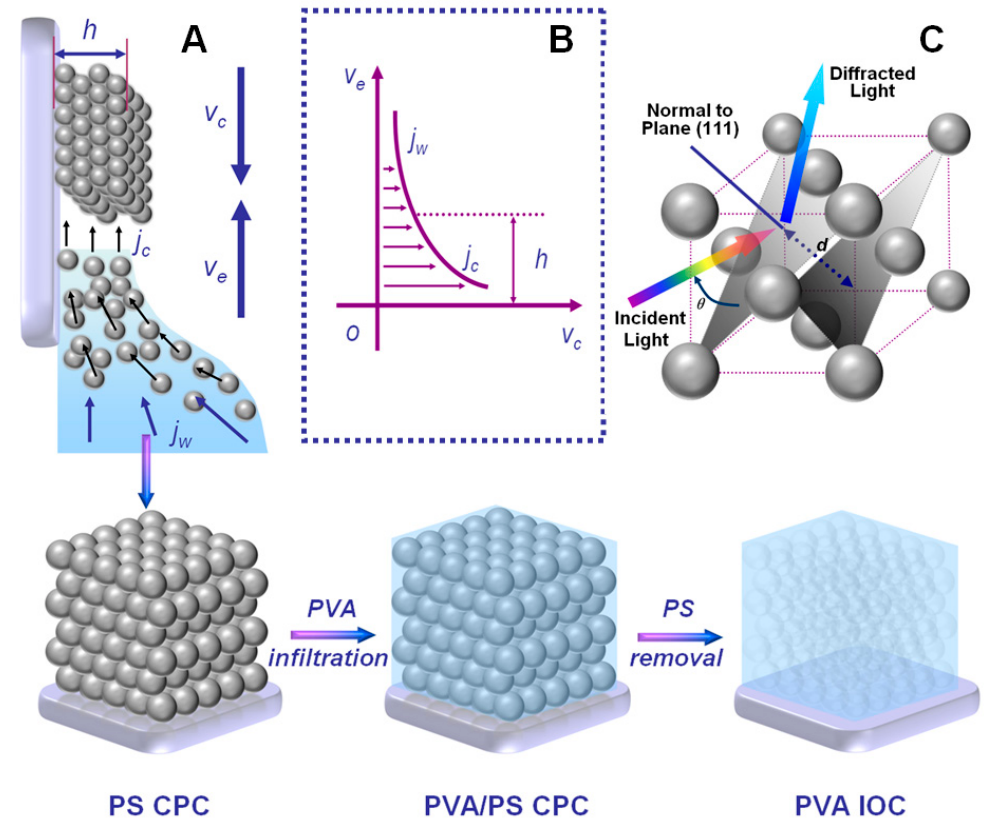
Figure 1. ( A ) Preparation scheme of PVA IOC; ( B ) growth mechanism of opaline PS CPC; ( C ) diffraction principle of CPC materials.